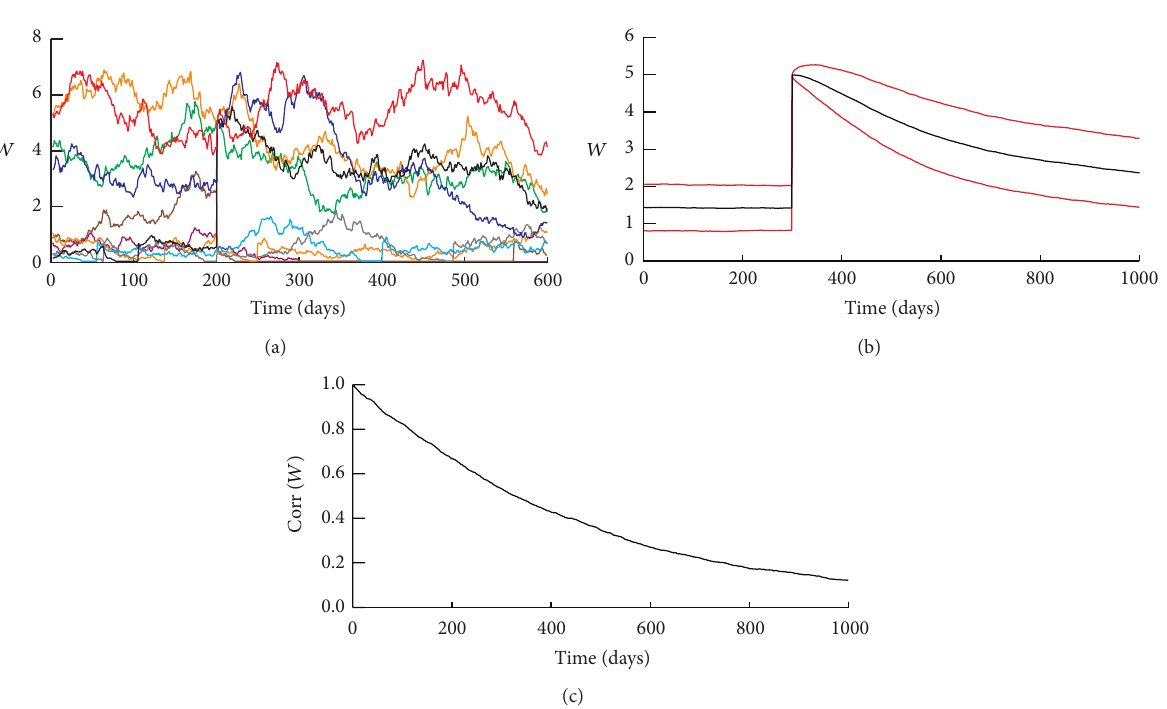
Figure 5: Weight dynamics with imposed LTP of a subset of synapses. (a) A representative time course of a 10-synapse cluster. 𝑡 = 0 corresponds to the distribution of Figure 2(a). At 𝑡 = 200 days, 𝑊 was set to a high value of 5 for synapses 1–5 and a low value of 0.5 for synapses 6–10. Over 400 days the distinction between strong and weak synapses was largely preserved, with synapses 1–4 remaining at high weights. (b) Dynamics of the potentiated synapses in 10,000 10-synapse clusters. For each cluster, synapses 1–5 were potentiated as in (a); thus dynamics of 5000 synapses are illustrated. Black trace, time course of the average weight of these synapses. Red traces, ± 1 standard deviation from average. 700 days after LTP, the average weight remains > 1 standard deviation above the steady-state average. (c) Correlation coefficient describing the evolution of synaptic weights during maintenance of the steady-state distribution. For 10,000 synapses in 10-synapse clusters, in the distribution of Figure 2(a), the Pearson correlation coefficient 𝑅 was calculated between the values of 𝑊 at 𝑡 = 0 and the values at later